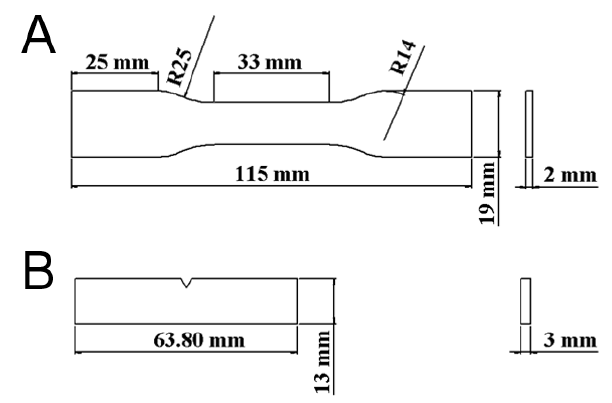
Figure 2. Layouts and dimensions of the ( A ) tensile test part and ( B ) impact test part.